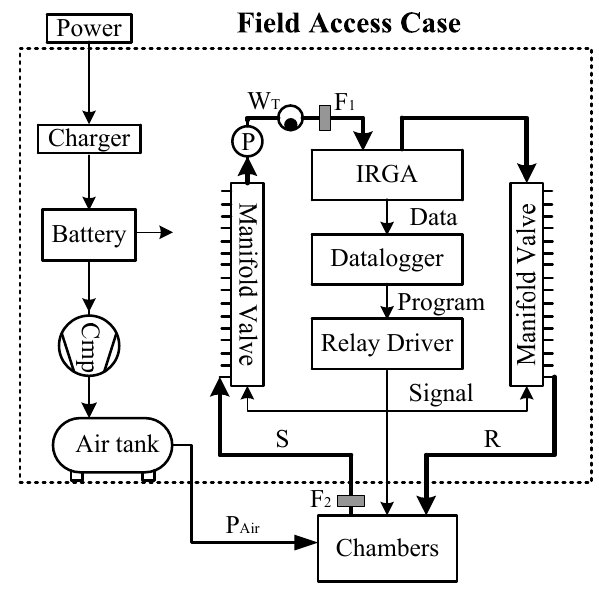
3 Fig. 1. Schematic illustration of the multi-channel automated cham- ber system for continuous measurement of soil CO 2 efflux. The dashed square means a water proofed aluminum casing (Field Ac- cess Case). Bold arrows indicate the direction of chamber air- flow. Abbreviations: Power=DC 12V or AC 85–240V for the system; Charger=AC-DC convert for charging and controlling a 12V (7.2A · h) lead-acid battery that drives the system; Cmp=air compressor; P Air =compressed air from the air tank to the pneu- matic cylinders for opening and closing the chamber lids; F 2 =air filter (0.5mm mesh); S=sample air from the chamber; P=sample pump; W T =water trap; F 1 =air filter (1µF mesh); IRGA=infrared gas analyzer; R =sampled air returned to the